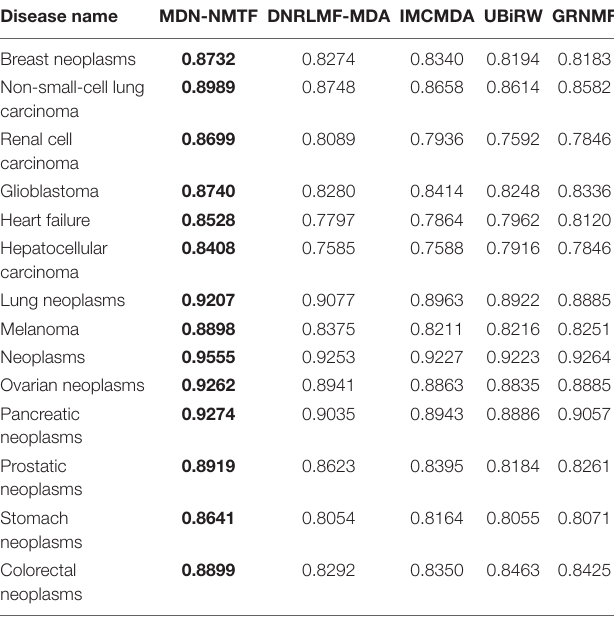
TABLE 3 | AUC values of MDN-NMTF and other four compared methods for the 14 diseases on HMDD2.0-Yan Dataset. Disease name